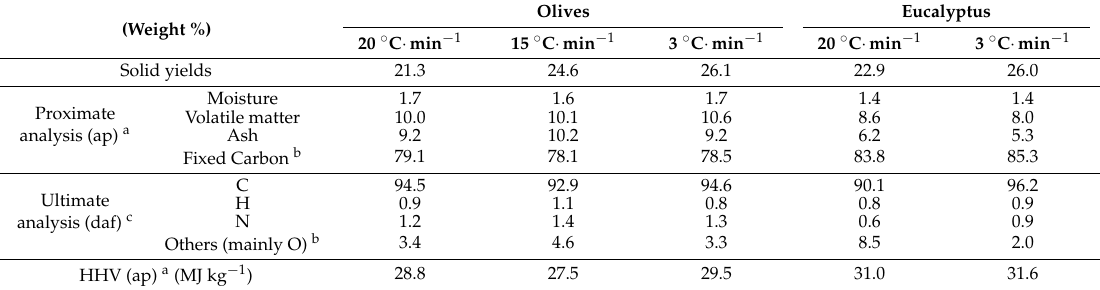
Table 3. Characteristics of the pyrolysis solids obtained at different heating rates (750 ˝ C). (Weight